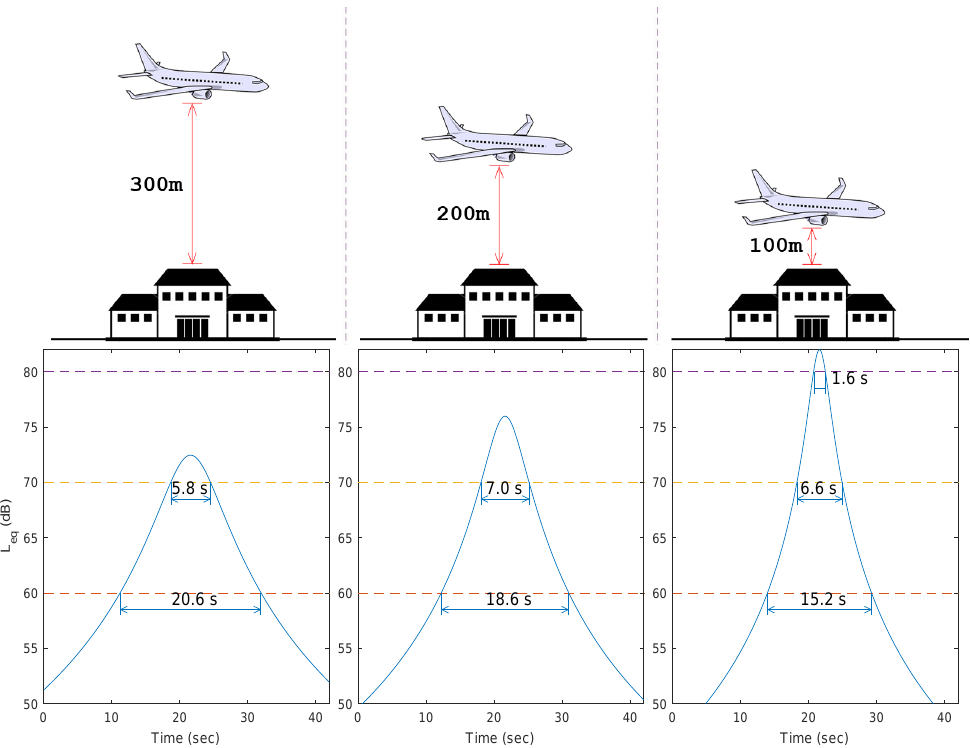
Figure 8: Example of sound pressure level and TA behavior during landing